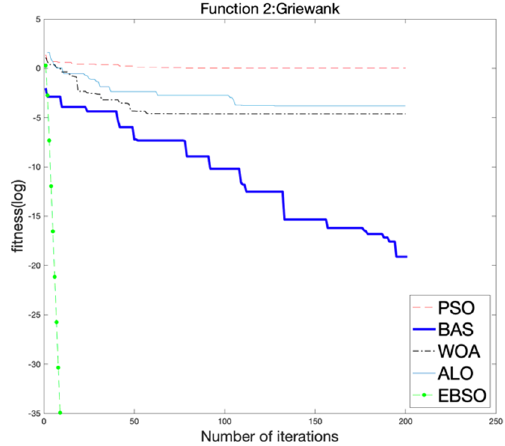
Figure 8. Iterative convergence graph.